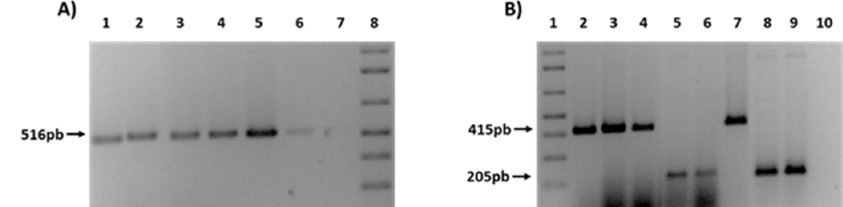
Figure 4. PCRs for the ESBL genes detection in transconjugants. ( A ) Presence of TEM-1 gene. 1: 1F; 2: